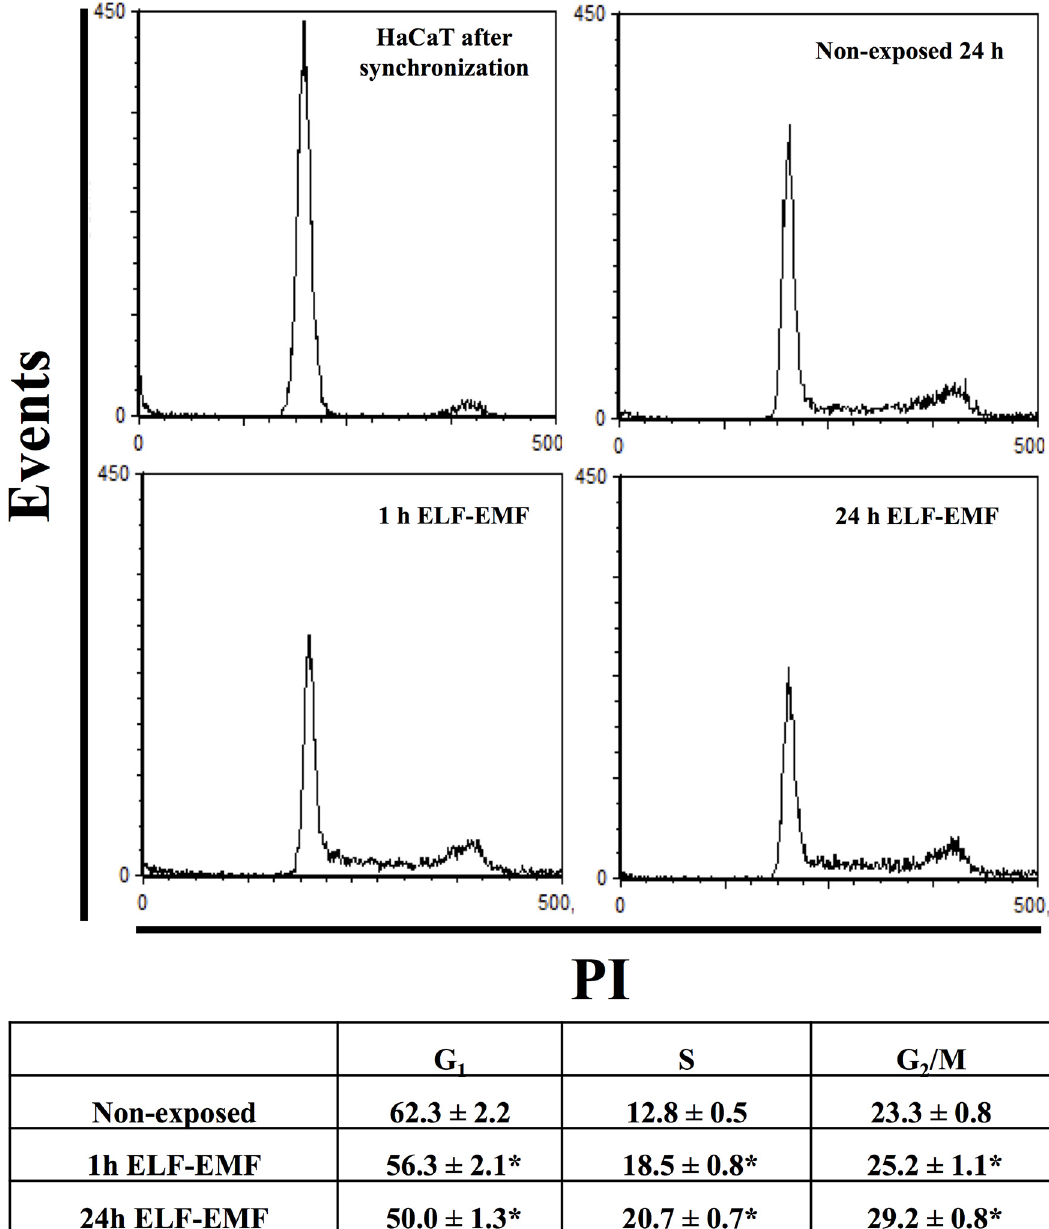
Fig 1. Cell cycle analysis. Flow cytometry cell cycle analysis of HaCaT cells exposed to ELF-EMF (1 mT, 50 Hz) for 1 and 24 h, using PI (40 μ g/ml) as probe. Percentage of fluorescent cells for G0/G1, S and G2/M phases were reported in the bottom panel. Mean ± SD of three analyses is reported. * p < 0 . 05 vs non-exposed